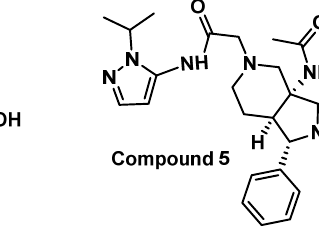
Figure 3. Chemical structures of BO ‐ I, His ‐ CutC ‐ I, and compound 5.